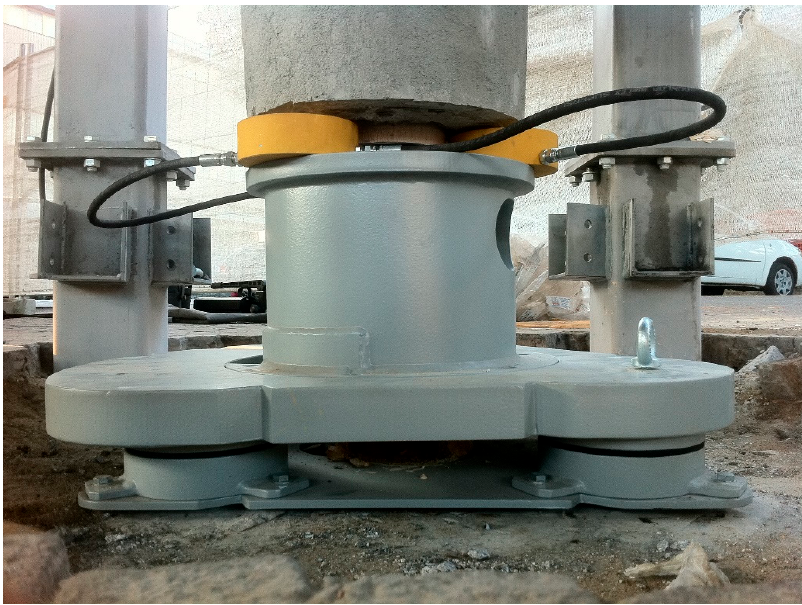
Figure 19. Picture of one of the tripods during its loading by means of three hydraulic jacks.